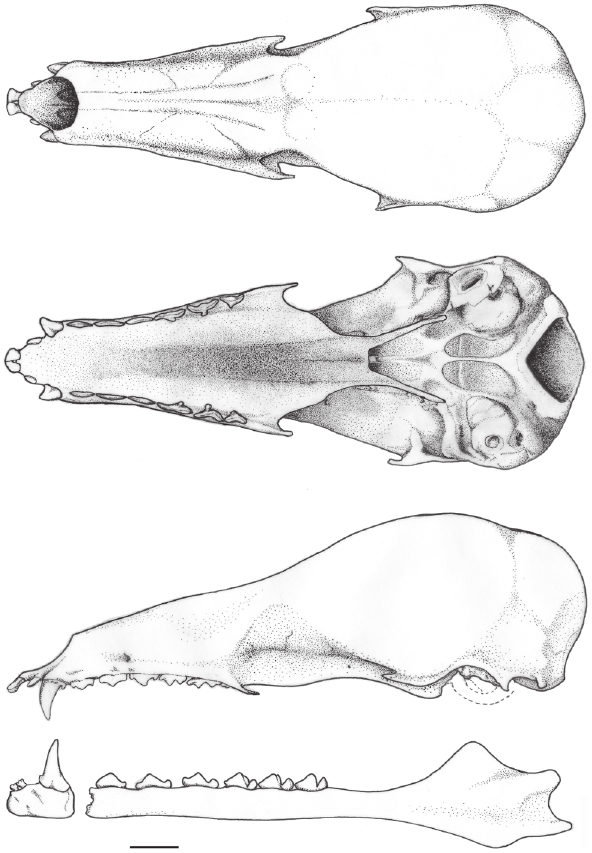
Figure 1. Skull and mandible of Xeronycteris vieirai (ALP 6824) from the region of Jaíba, Minas Gerais, Southeastern Brazil. Scale bar: 2